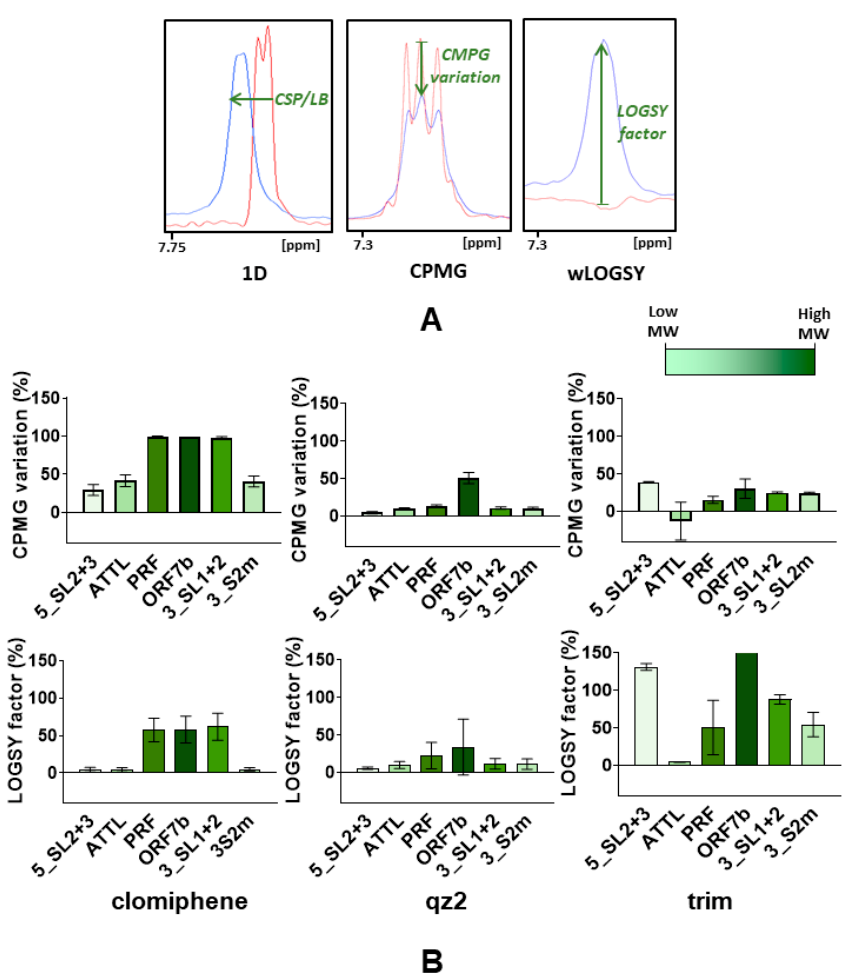
Figure 4. Interaction of clomiphene citrate, qz2 and trim with SCoV2 RNA elements analyzed by ligand-based NMR spectroscopy experiments. ( A ) Representative 1 H one-dimensional (1D) CPMG, and wLOGSY spectra of trim in the absence (red) and presence (blue) of 5_SL2+3. RNA binding was assessed by quantifying chemical shift perturbation (CSP) or line broadening (LB) in 1D spectra, peak area variations in CPMG spectra, and LOGSY factors in wLOGSY spectra. ( B ) Quantification of CPMG and wLOGSY perturbations of aromatic protons as a function of compound and RNA element. RNA elements are ordered according to their relative locations in the virus genome. For RNA targets of similar size, increased binding translates into greater variations of CPMG areas and greater LOGSY factors. Note that both CPMG and LOGSY perturbations intensify with RNA target size. To account for this effect, the CPMG and LOGSY bars are colored according to the size of each RNA element as depicted in the image. The error bars represent the standard deviation of the average perturbation detected for the aromatic protons of each ligand. Conditions for ( A ) and ( B ): 300 μ M compound; 3 μ M RNA (1:100 molar ratio; clomiphene) or 6 μ M RNA (1:50 molar ratio; trim and qz2); 150 mM KCl and 3 mM MgCl 2 ; 100 ms CPMG delay; 27 °C.